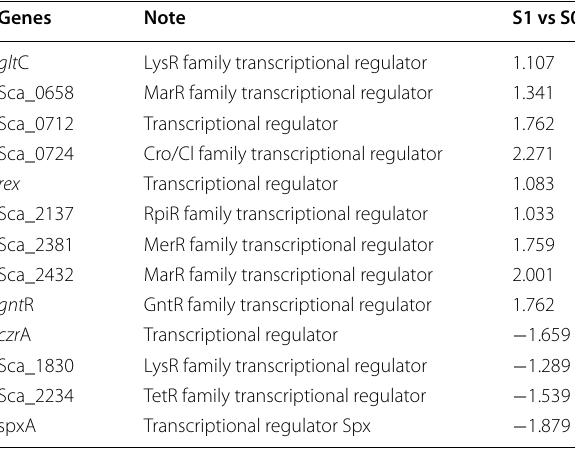
Table 3 DEGs related to transcriptional